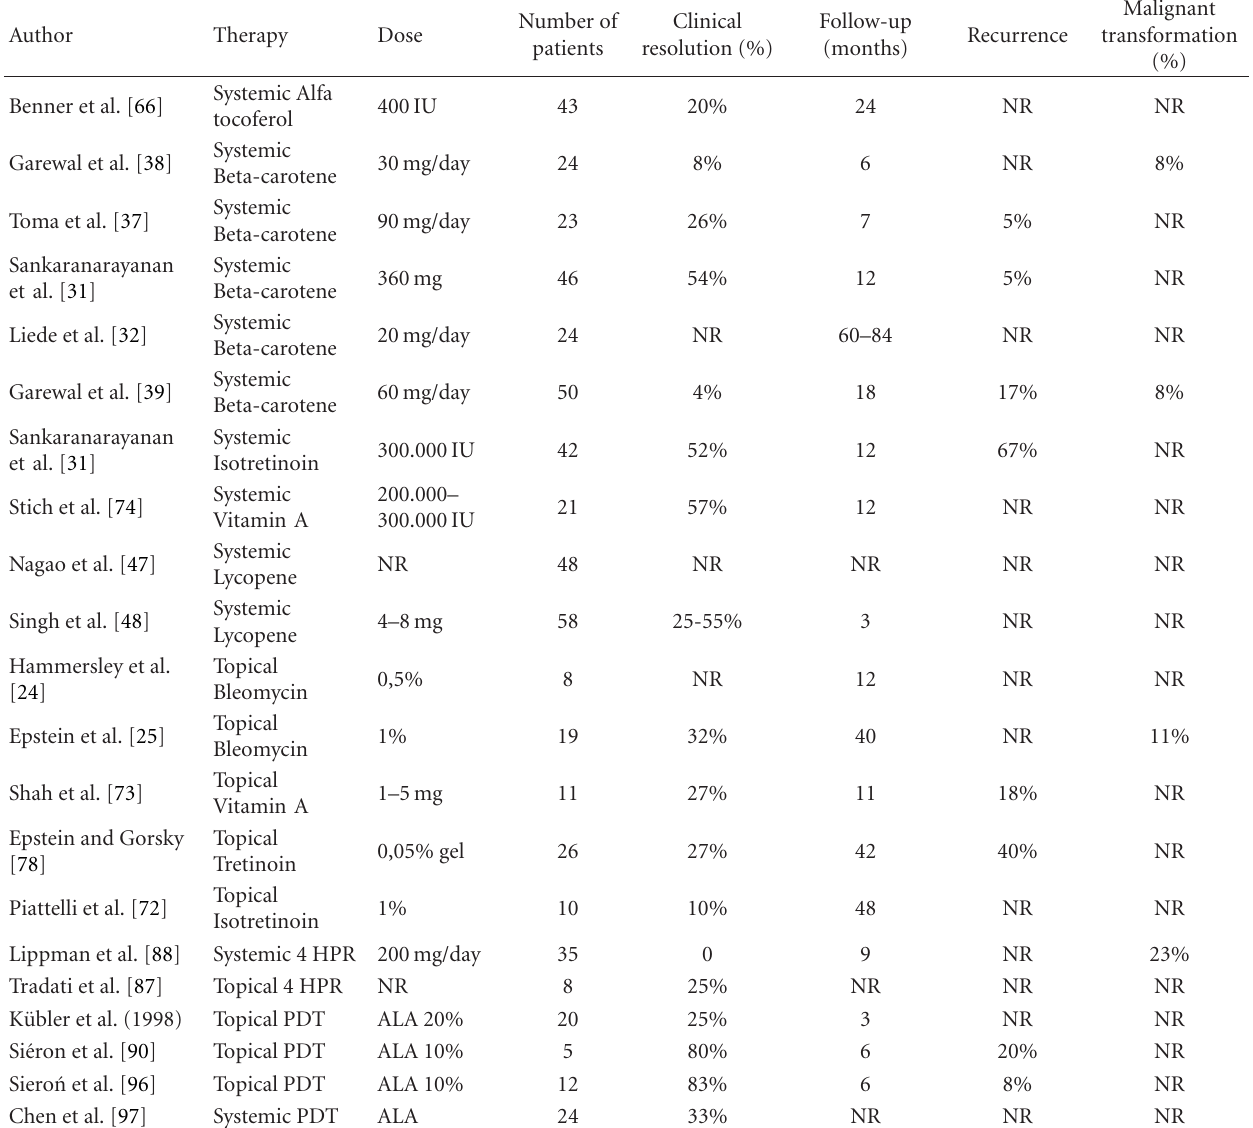
Table 1: Nonsurgical treatments options for oral